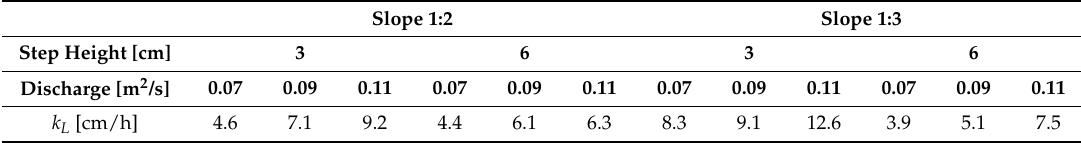
Table 5. Deduced mass transfer velocities for all configurations. Slope 1:2 Slope